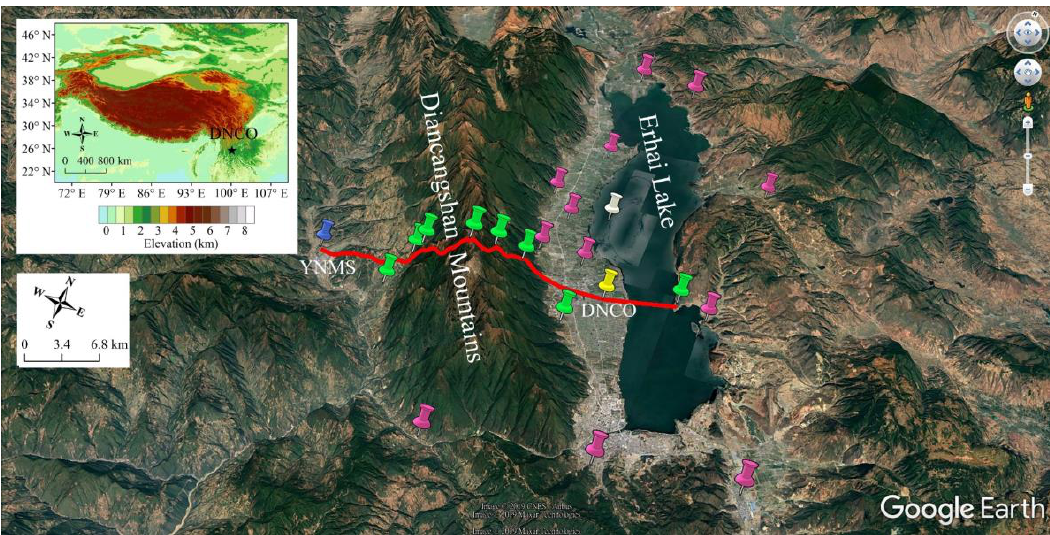
Figure 1. Location of the Dali National Climate Observatory (DNCO) and its topographic situation as well as the network layout for the integrated meteorological observations over a typical terrain region. Yellow marker: the DNCO; blue marker: the Yangbi National Meteorological Station (YNMS); white marker: observation platform over Erhai Lake; green markers: typical profile observation stations of mountain meteorology; pink markers: six-factor automatic weather stations around Erhai Lake. The map was from the Google Earth.